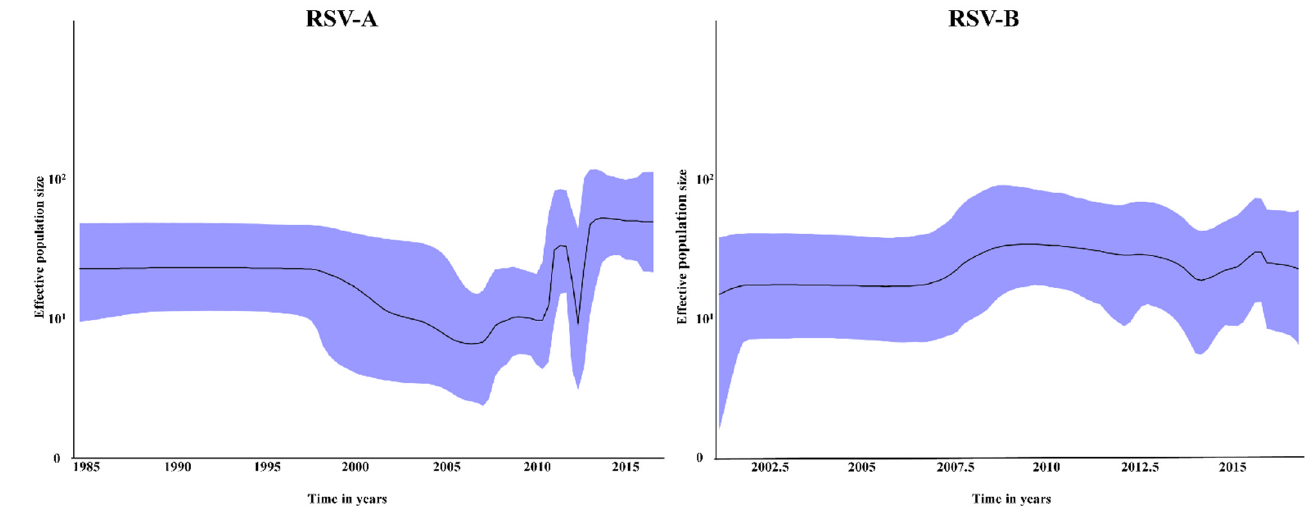
Figure 3. Bayesian skyline plot.